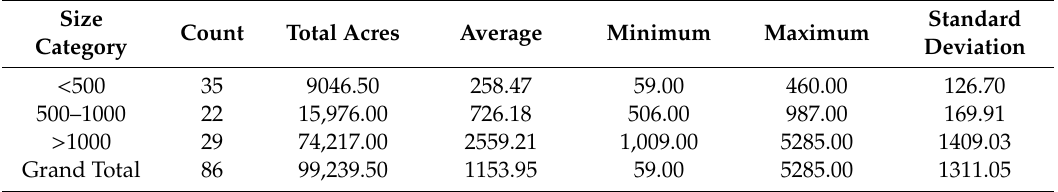
Table 1. Descriptive statistics of 86 working forest conservation easements (WFCEs) in Georgia.